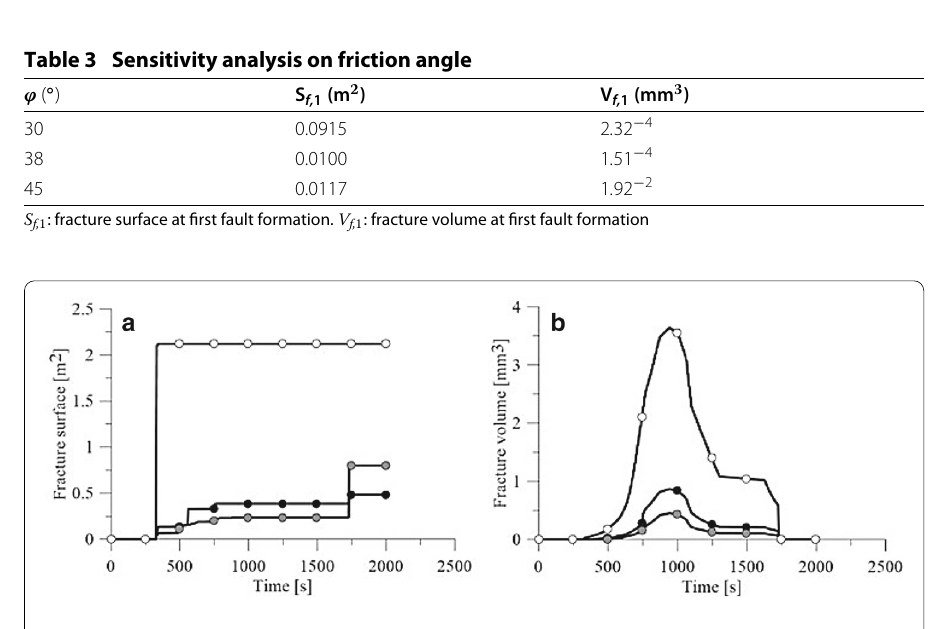
Fig. 10 Sensitivity analysis on the initial isotropic permeability of the matrix. Black circles: 2 × 10 − 14 m 2 .